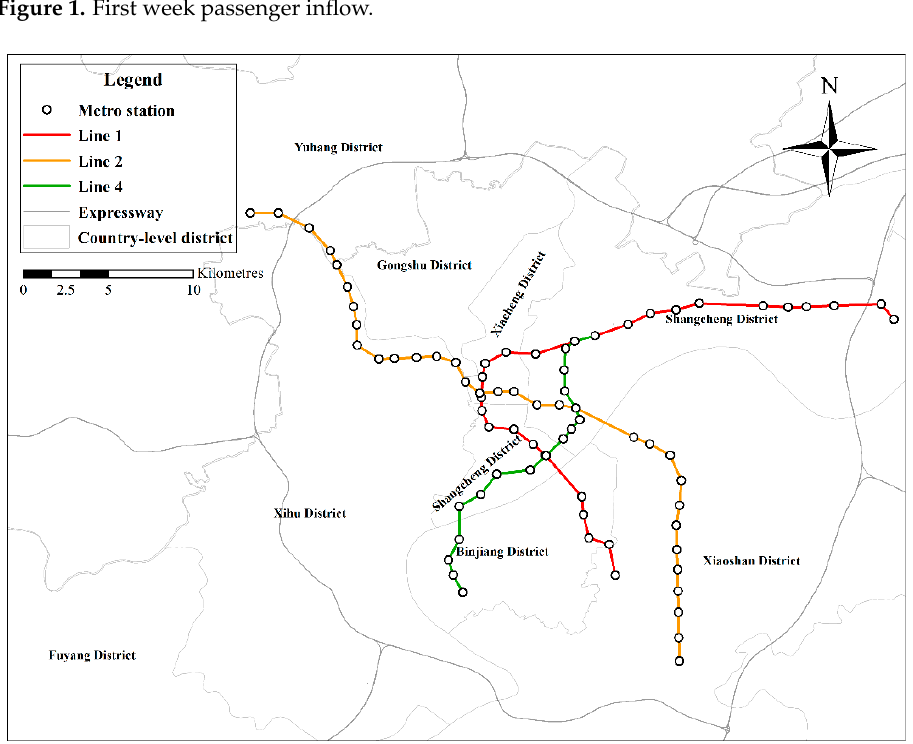
Figure 2. Distribution of metro stations.